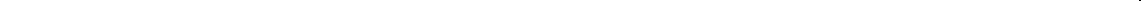
Fig. 7 Downregulation of CX 3 CR1 affects fatty acid uptake in serous ovarian carcinoma cell lines. OVCAR-4 and SKOV-3 were transiently transfected with either control (CTRLsi) or CX 3 CR1-speci fi c (CX 3 CR1si) siRNAs and a subjected to QBT fatty acid uptake assay. Three independent experiments were averaged and data plotted. * p < 0.05, two-way ANOVA. b On the third day after transfection, cells were treated with 500 μ M of linoleic acid for 24 h and stained with Oil red O dye and DAPI followed by fl uorescence imaging (shown, OVCAR-4). Cells not incubated with linoleic acid were used as controls to determine the baseline fatty acid contents. Bar, 50 μ m. All images across the same experiment were imaged using the same exposure time to enable quantitative comparison of immuno fl uorescence signals. Lipid contents in the cells in the entire fi eld of view were quanti fi ed with ImageJ (NIH) software and are shown as surface plots. c Images were superimposed from red and blue channels. Three independent experiments were performed with each cell line, ten random fi elds for each condition and imaged. Fatty acid uptake was quanti fi ed by mean fl uorescence/cell using ImageJ software and plotted. * p < 0.05, Student ’ s t test. Bar, 20 μ m. d Genes, as indicated (Gene B column), expression of which strongly correlated with expression of CX 3 CR1 in specimens from patients, as determined using cBioportal database for serous ovarian cystadenocarcinoma (TCGA, Nature 2011 dataset). Expression of GPR65 ( e ) and FFAR4 ( f ) mRNA as a function of CX 3 CR1 mRNA expression in specimens of ovarian cystadenocarcinoma was determined using cBioportal database (left panels: TCGA, Nature 2011 dataset, n = 557; center panels: TCGA, Provisional dataset, n = 603). Expression of GPR65 and FFAR4 in HGSOC cell lines (shown: SKOV-3) transiently transfected with either control (CTRLsi) or CX 3 CR1-speci fi c (CX 3 CR1si) siRNAs or transfected with vehicle (NT) was determined using western blot (left panels). ACTB was used as a loading control. Data (an average of three experiments) were analyzed with digital densitometry using BIO-RAD Chemidoc software, averaged, and plotted. * p < 0.05, Student ’ s t